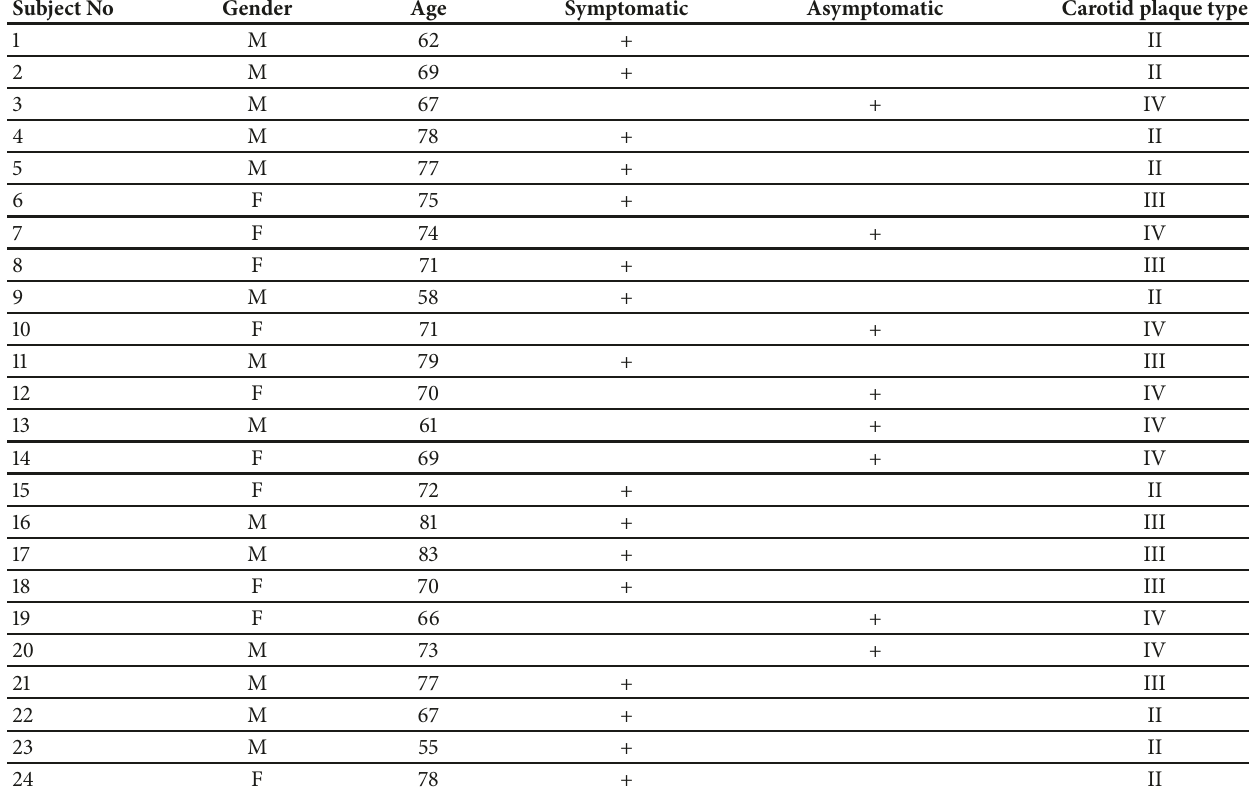
Table 1: Patient’s demographic, clinical characteristics and plaque